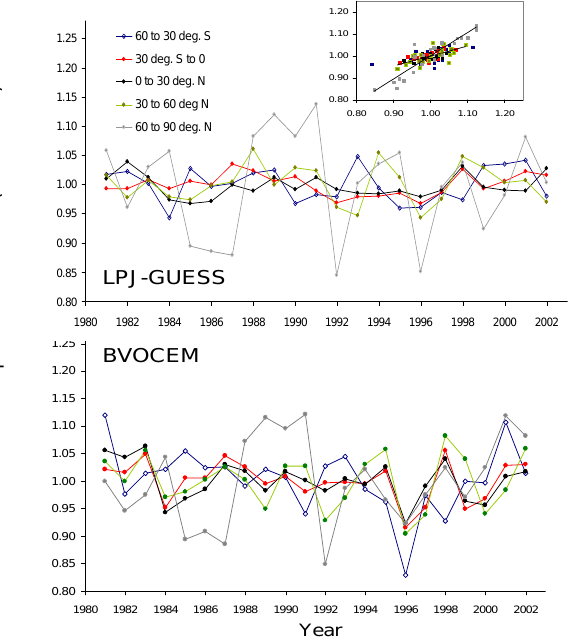
Fig. 5. Annual total emissions from LPJ-GUESS (top panel) and BVOCEM (bottom panel), separated by latitudinal band, over the 22-yr simulation period. Simulations were performed by apply- ing the CRU climate and with dynamic vegetation features enabled. CO 2 concentration affected vegetation productivity, but the direct effects of CO 2 on isoprene production were disabled. Data were normalised to unity by the average emission rate over the simula- tion period, and a linear trend was removed. The inset shows the correlation between the two models, with a separate regression for the northernmost latitudinal band (60–90 ◦ N, grey).